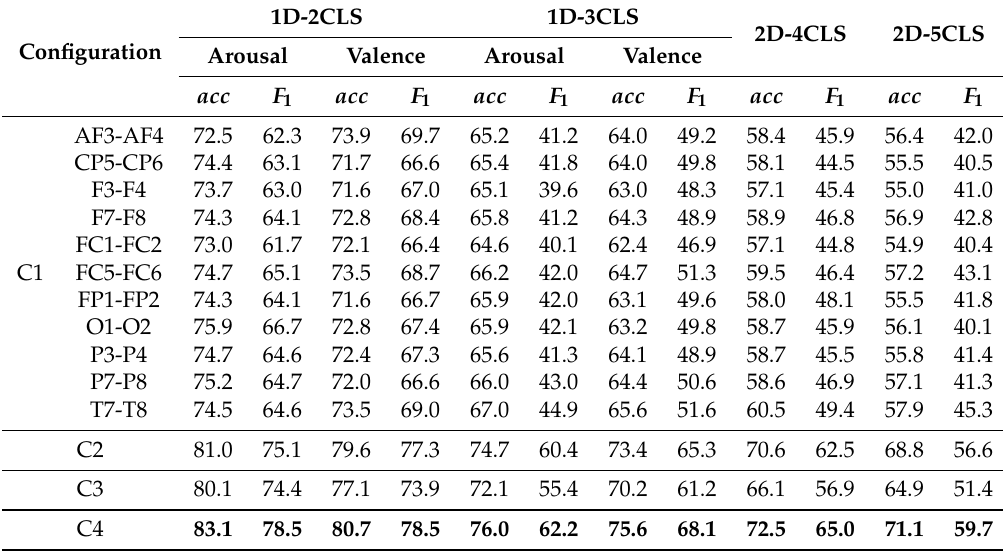
Table 6. Results of the channel-based evaluation analysis. Bold font is used to indicate the highest acc and F 1 values obtained for each combination of emotion labeling scheme and EEG channel